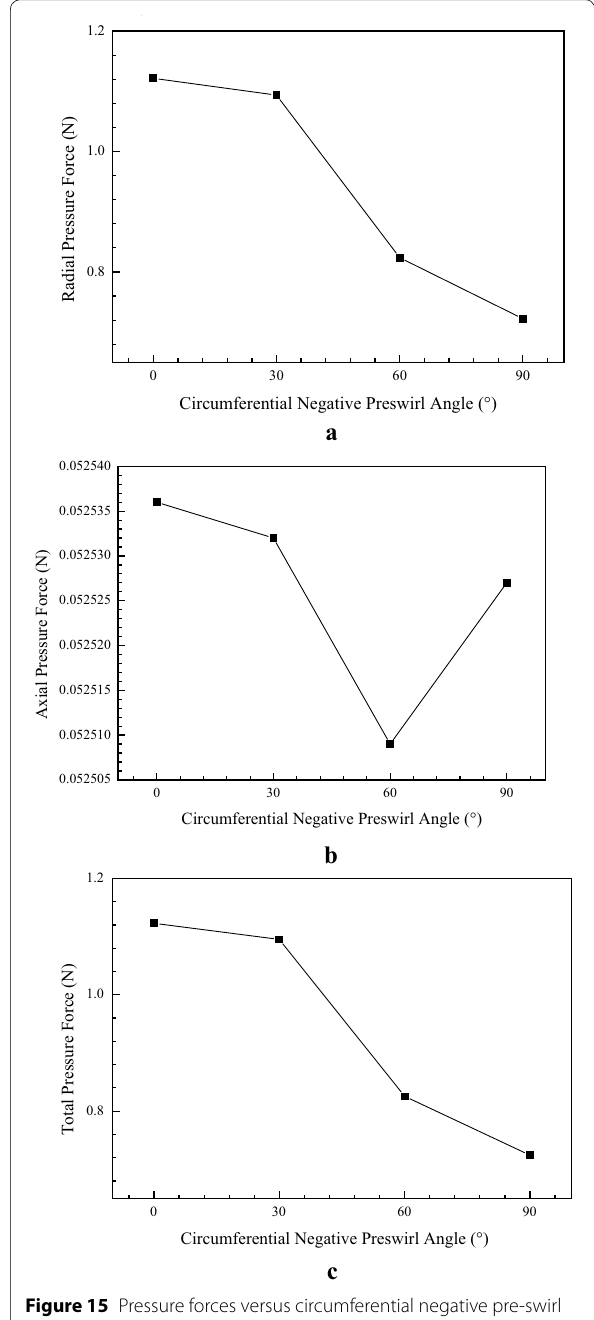
Figure 15 Pressure forces versus circumferential negative pre-swirl angle: a radial pressure force; b axial pressure force; c total pressure